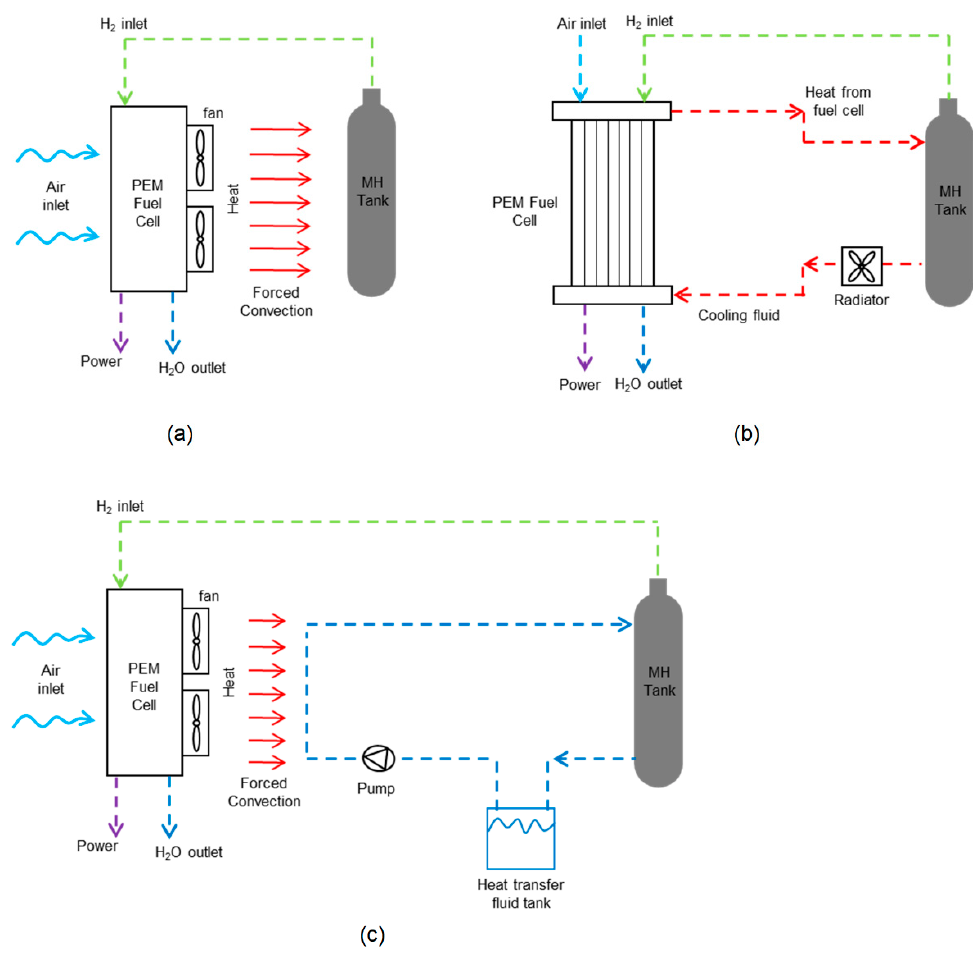
Figure 7. Active thermal management between a PEM fuel cell and an MH tank using ( a ) fan, ( b ) heat transfer fluid (Reproduced with permission from Ref. [37]. 2022, Elsevier.), and ( c ) fan and heat transfer fluid (Reproduced with permission from Ref. [27]. 2022, Elsevier.).